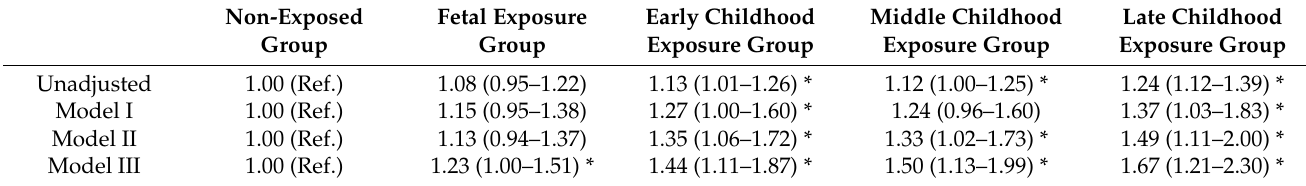
Table 2. Association between famine exposure in early life and the risk of MetS in adulthood, OR (95%